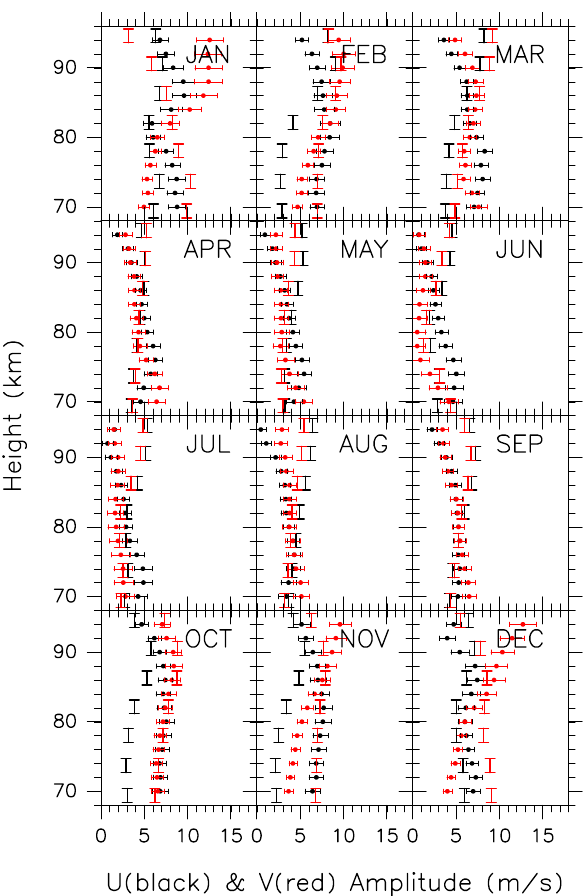
Fig. 3. Same as Fig. 2 except for diurnal phases in local solar